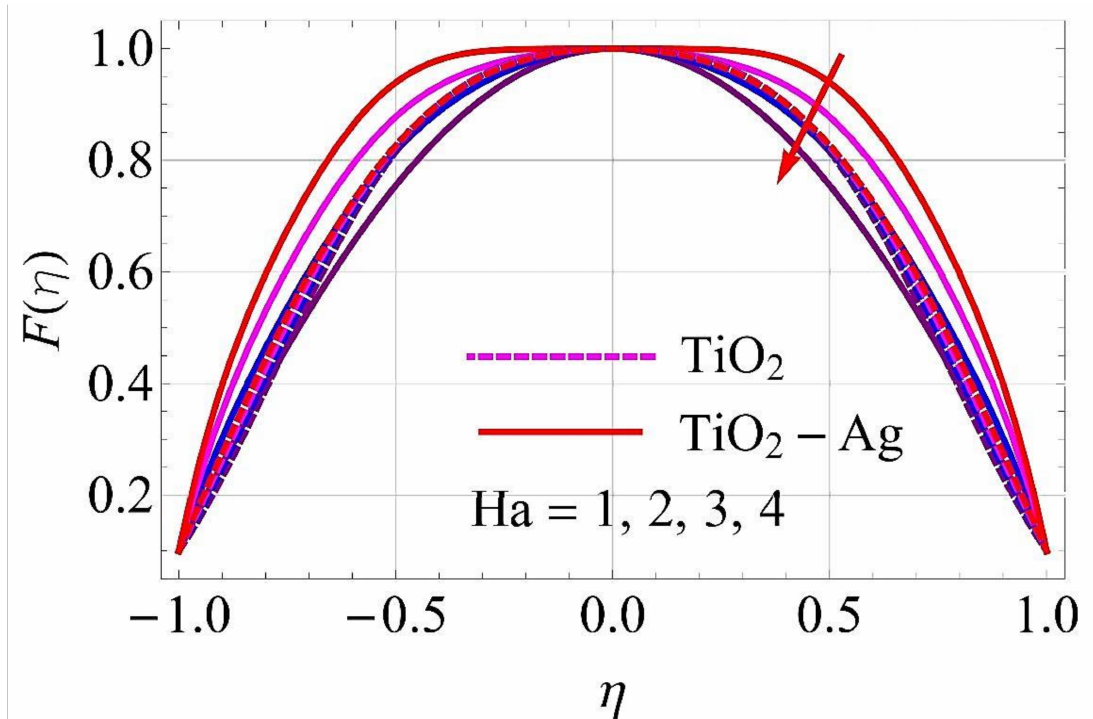
Figure 5. Velocity versus Ha with α = − 5 ◦ for converging/stretching circumstances. When Re = 25, φ 1 = φ 2 = 0.01, Rd = 0.4, Ec = Q = Fr = k ∗ = K 1 = 0.1 .